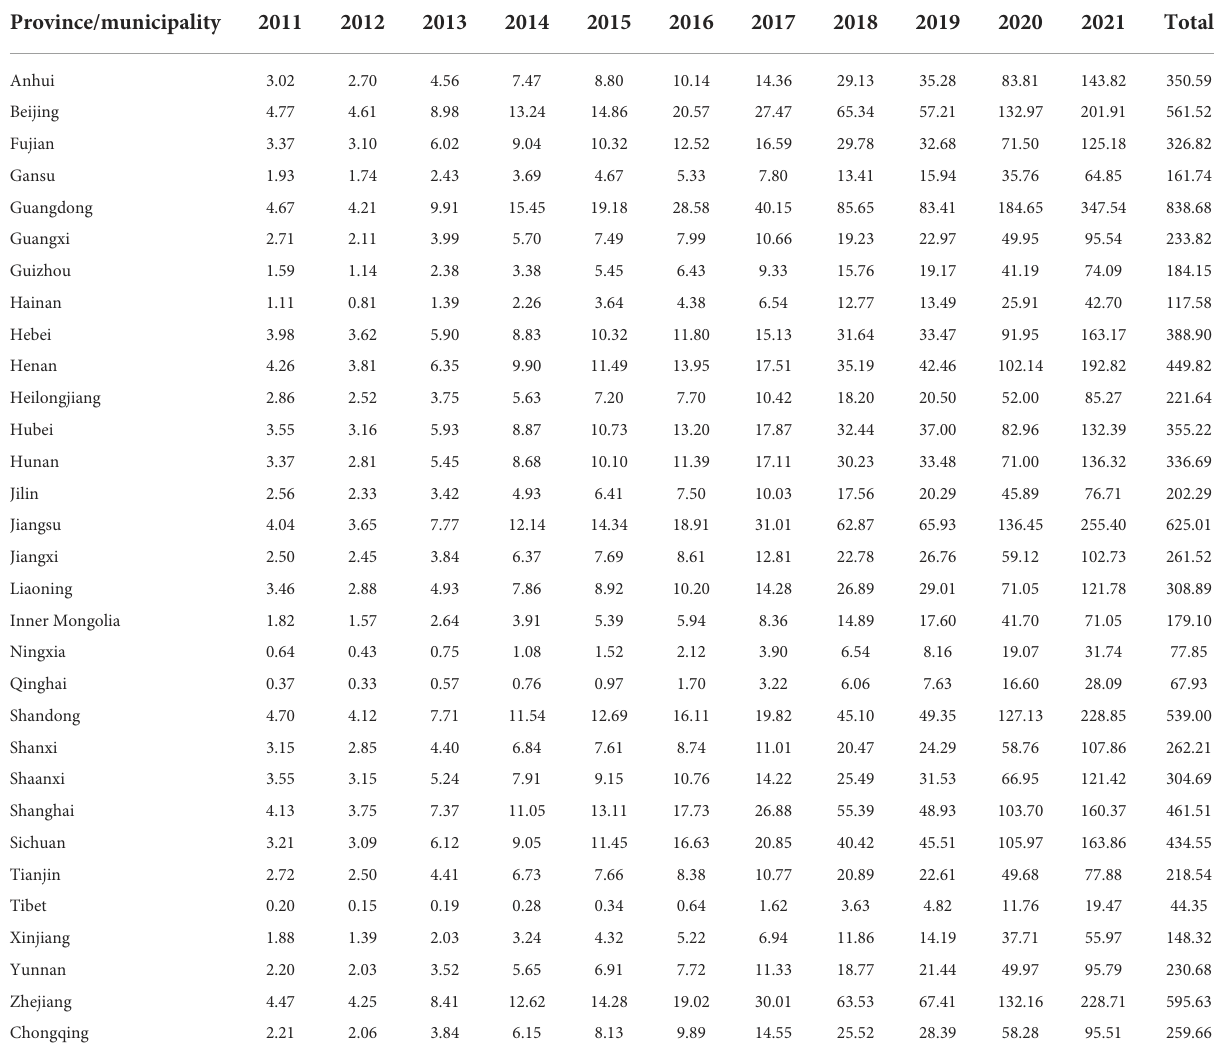
TABLE 2 OAV in each province/municipality between 2011 and 2021 (unit: